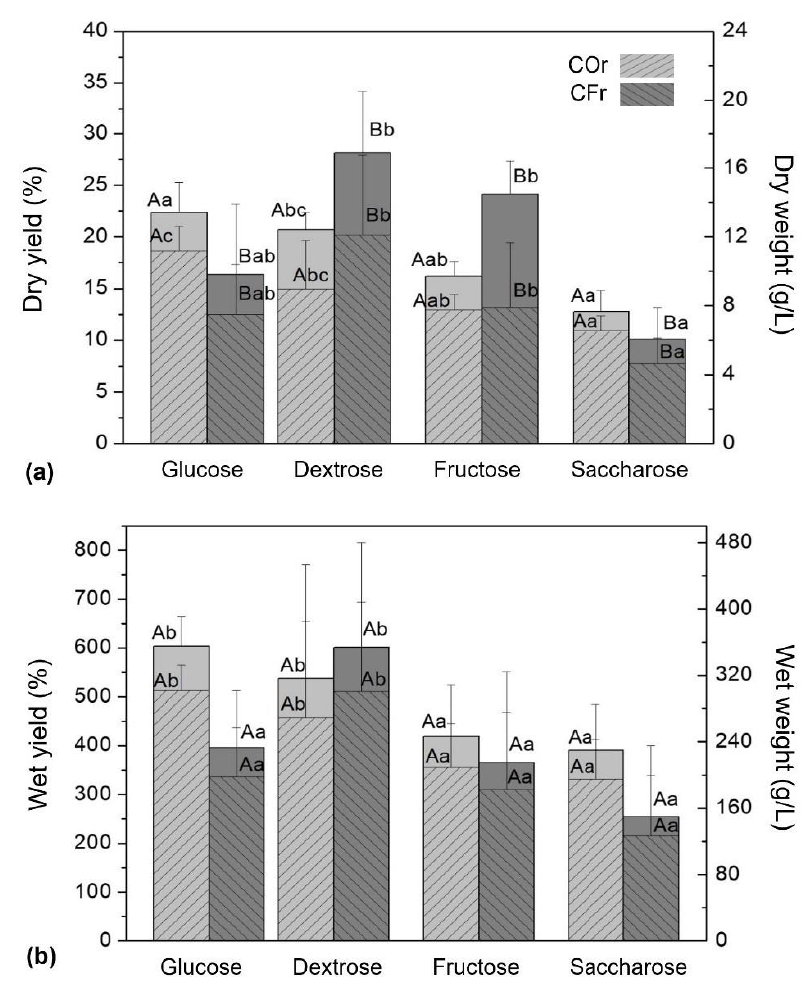
Figure 5. Yields of the microbial cellulose films obtained from COr and CFr consortia after 15 days of fermentation at 25 °C. ( a ) Dry basis and ( b ) wet basis.